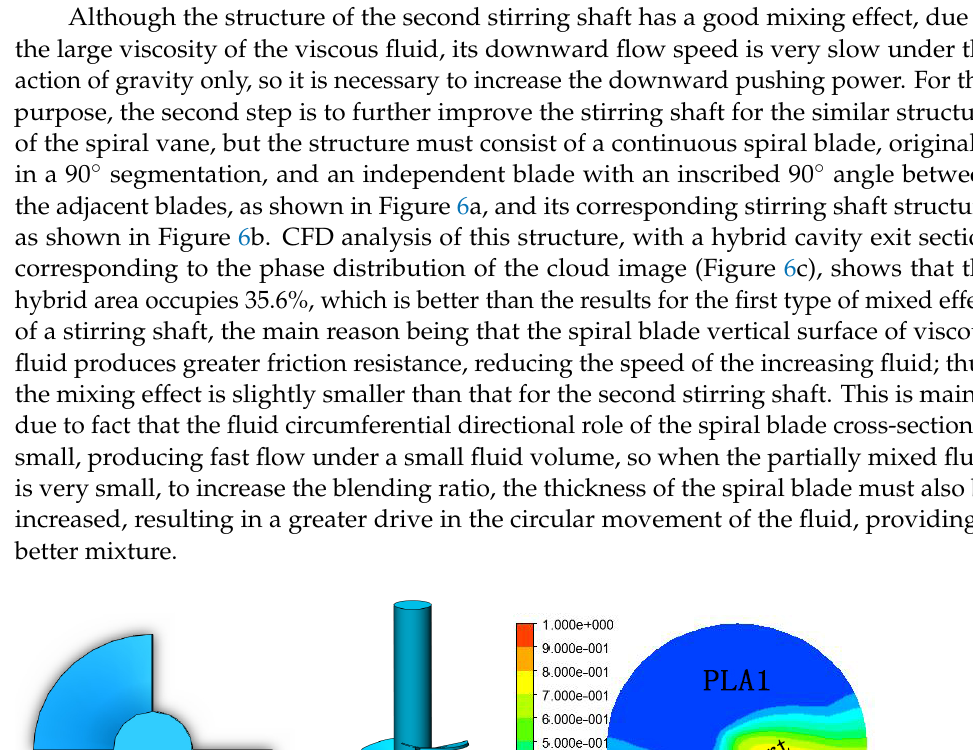
Figure 5. (a) Stirring shaft of rectangular spoiler and its simulation , and (b) the exit section phase distribution .